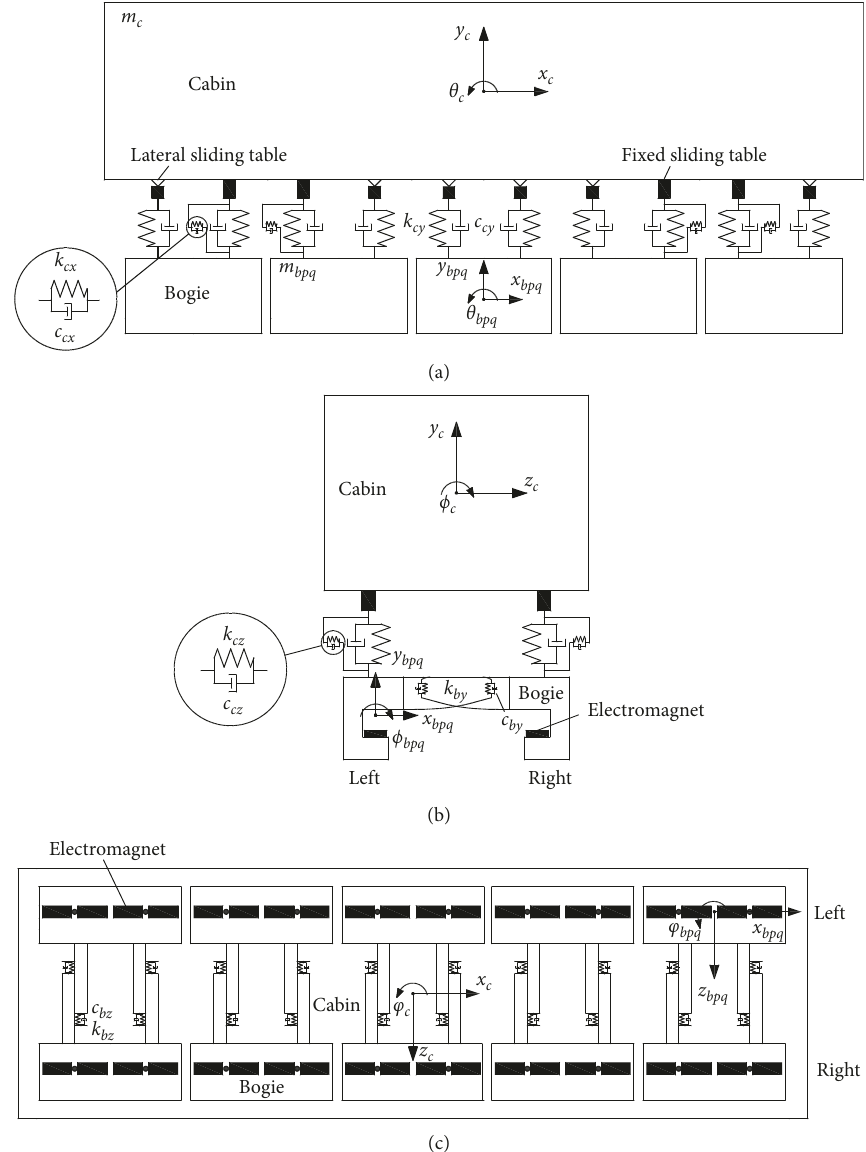
Figure 1: 3D middle-low speed maglev vehicle. (a) Side view. (b) Front view. (c) Plane